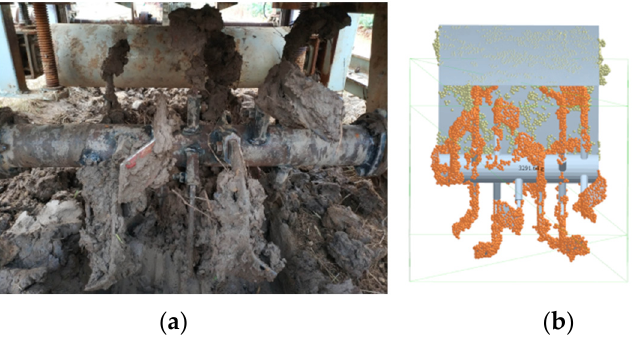
Figure 6. Results of soil adhesion test: ( a ) actual test ( b ) simulation test.